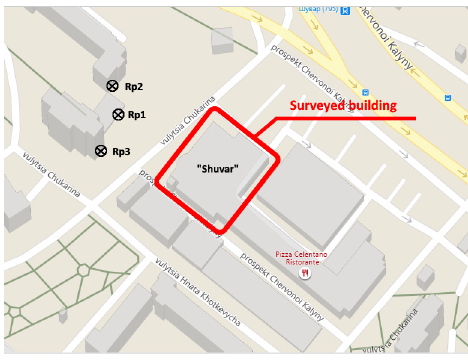
Figure 3. Location of wall benchmarks